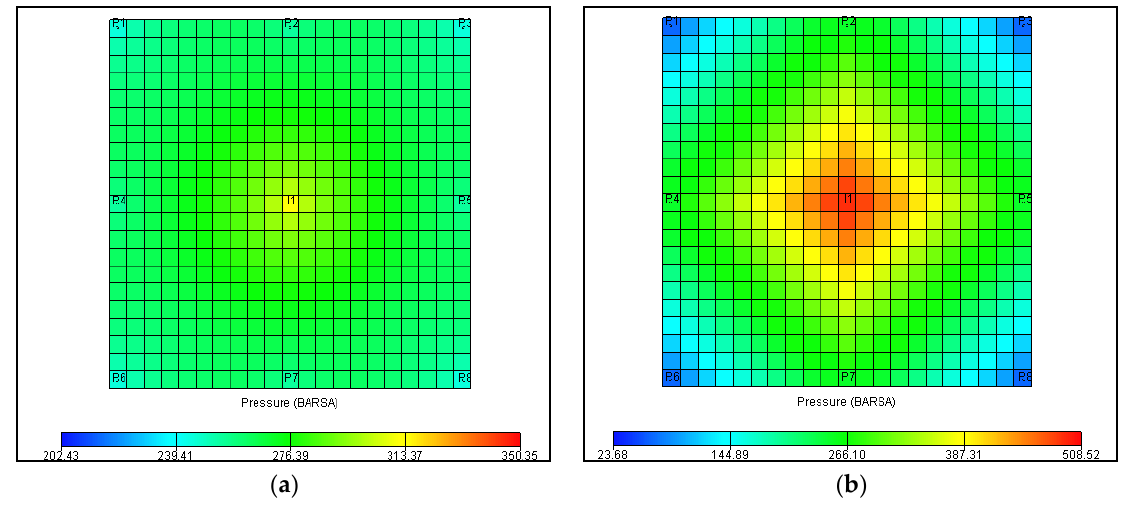
Figure 11. Pressure distribution map on June: ( a ) Darcy seepage; ( b ) non-Darcy seepage.